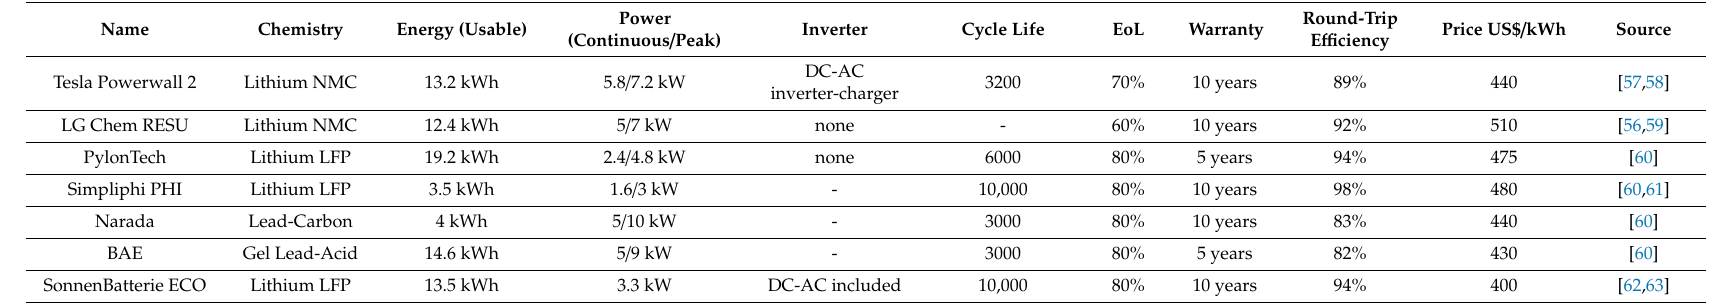
Table 2. Existing products and their